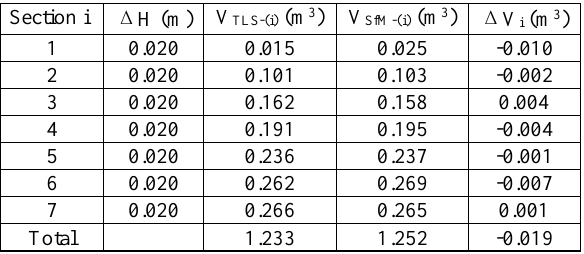
Table 2. Calculated volume for each section and total